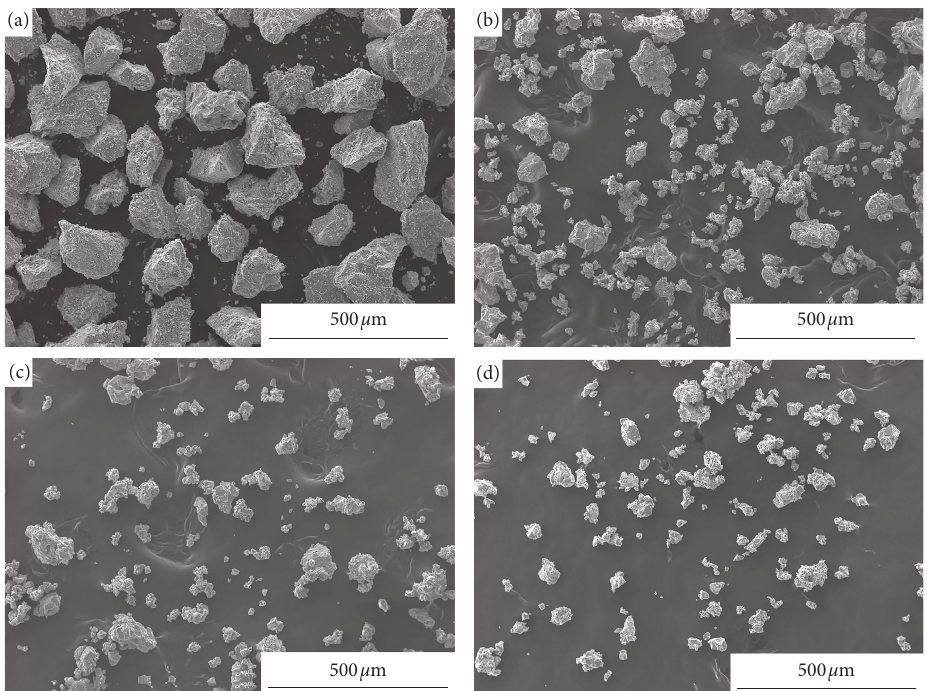
Figure 5: SEM images of TiH 2 powder: (a) initial particles (88–125 μ m) without compaction and particles after compaction at (b) 300MPa, (c) 450MPa, and (d)